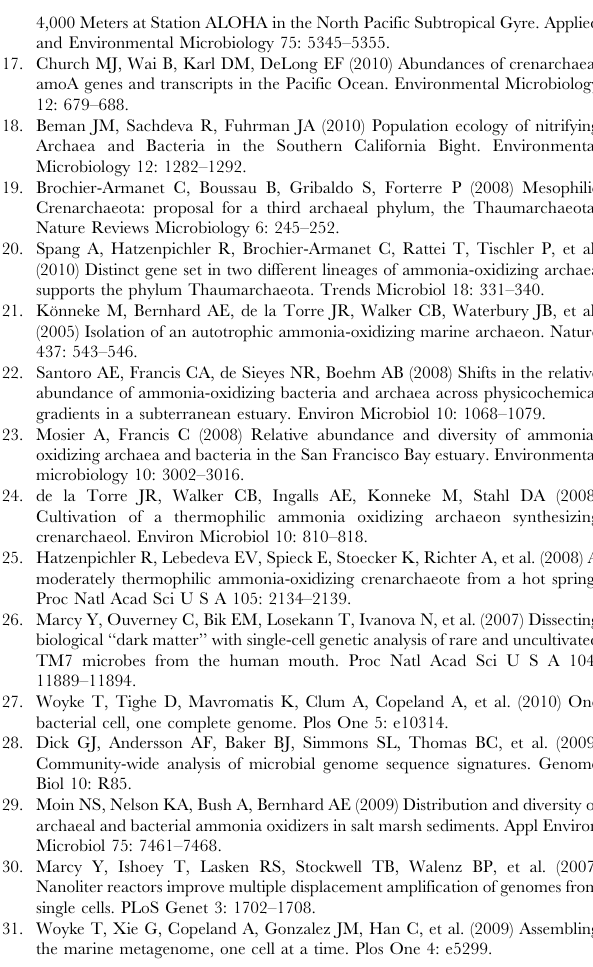
Table S1 Genes in N. limnia that are putatively involved in ammonia oxidation and respiration (Table modified from Walker et al. , 2010).